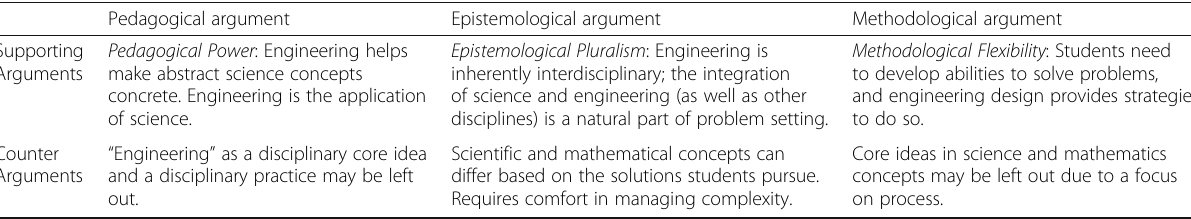
Table 2 Comparing arguments for integrating science and engineering Pedagogical